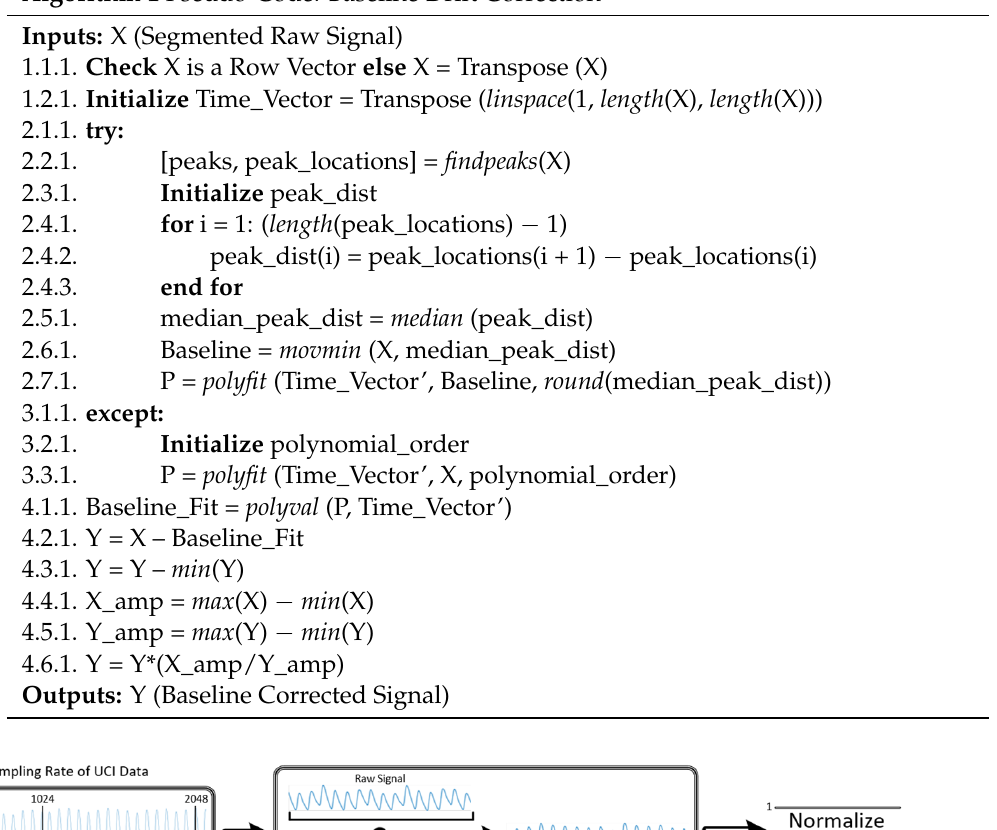
Algorithm 1 Pseudo-Code: Baseline Drift Correction